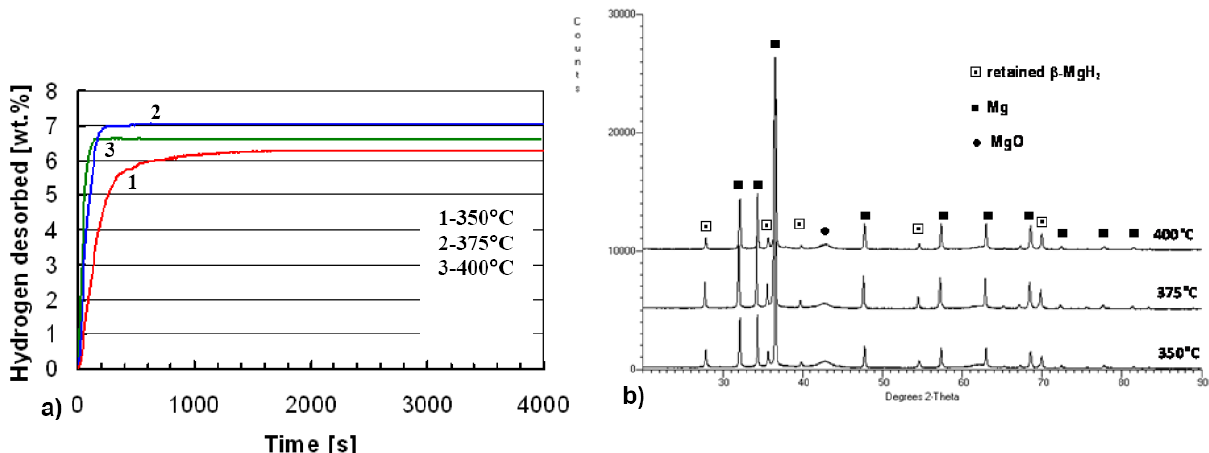
Figure 4. (a) Hydrogen desorption curves under 0.1 MPa H for MgH milled continuously in argon for 100 h. (b) XRD patterns of the same powders 2 after desorption. Adapted from